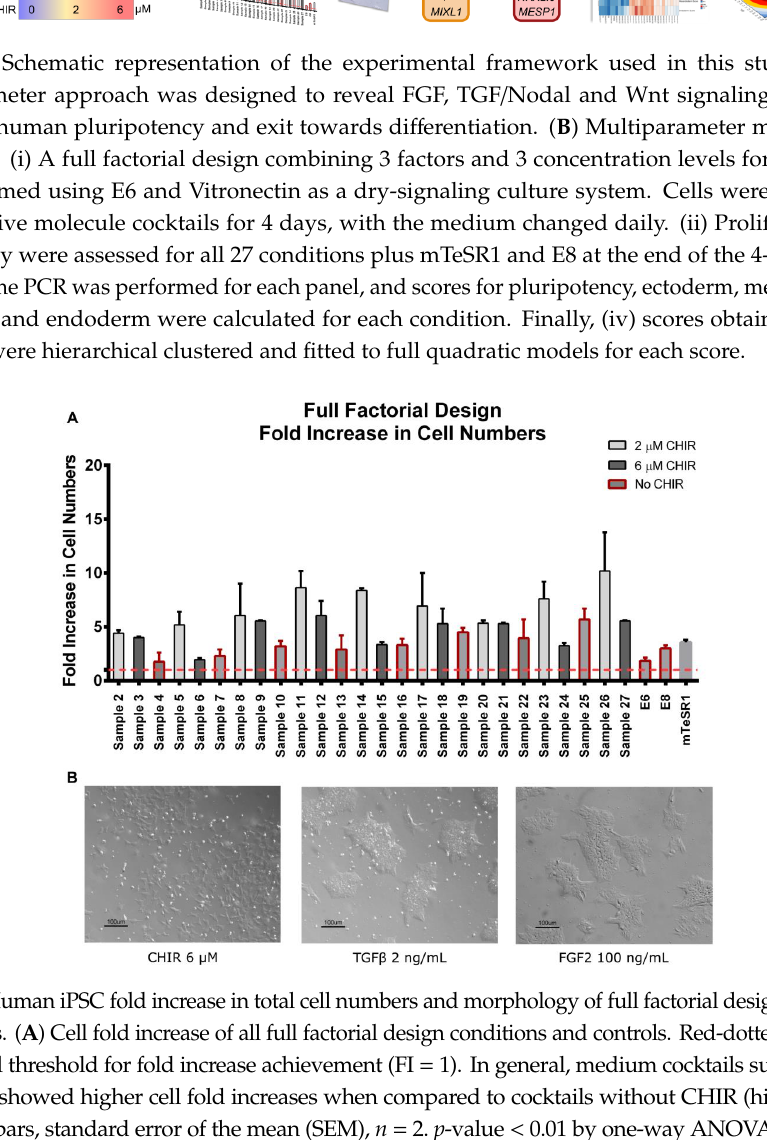
morphology of cultures with CHIR addition compared to cultures without CHIR addition after 72 h of supplementation showed no colonies, which is associated with a more committed phenotype. See